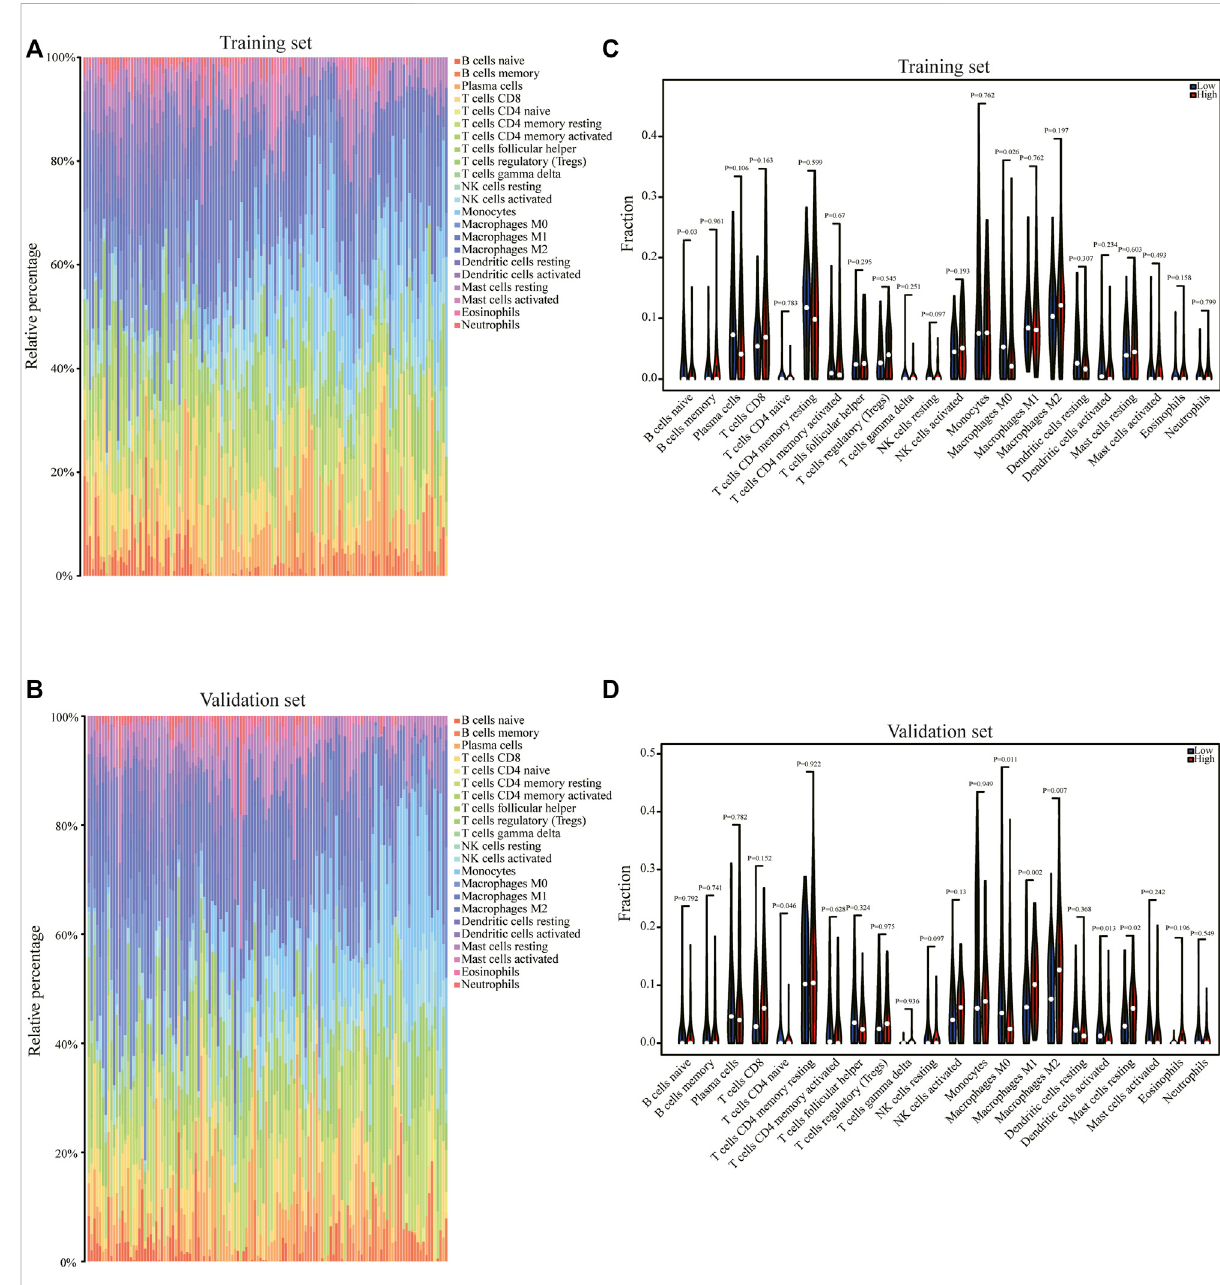
FIGURE 8 The correlation of pyroptosis scoring and immune cell in fi ltration. (A) The CIBERSORTx algorithm was used to analyze the immune cell in fi ltration of each sample in the training set. (B) The CIBERSORTx algorithm was used to analyze the immune cell in fi ltration of each sample in the validation set. (C) Relationship between the pyroptosis scoring and the expression of immune cells in the training set. (D) Relationship between the pyroptosis scoring and the abundance of immune cells in the validation